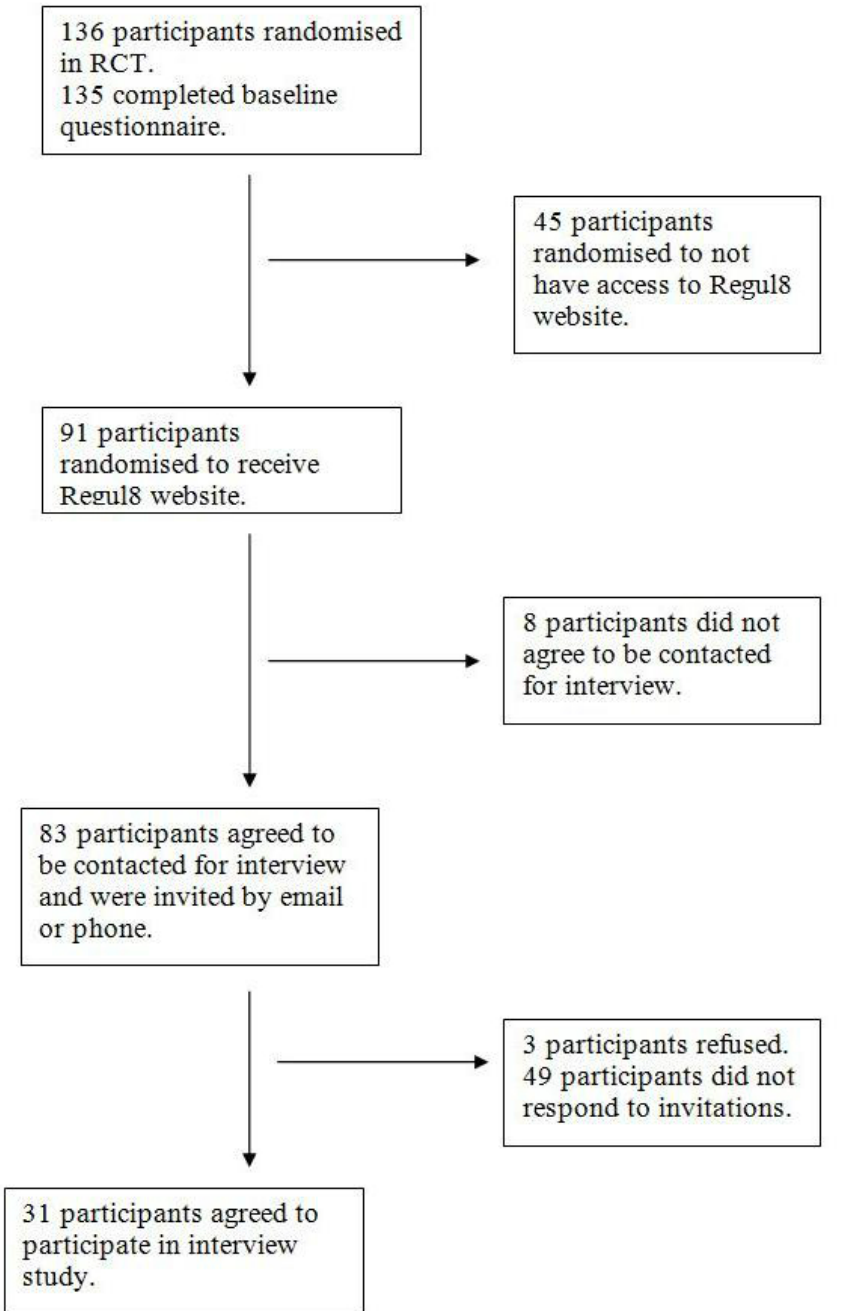
Figure 2. Flowchart showing how participants were identified from the original trial